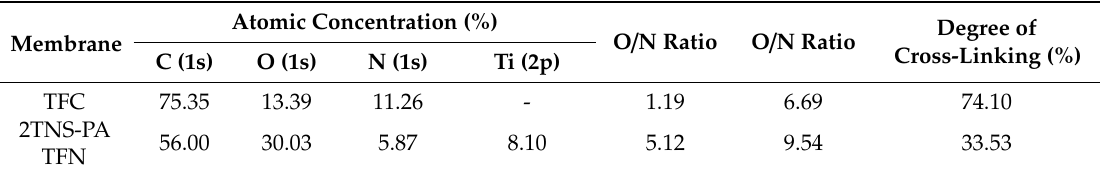
Table 1. Element composition, O / N ratio, C / N ratio and degree of cross-linking of TFC and TFN membranes.